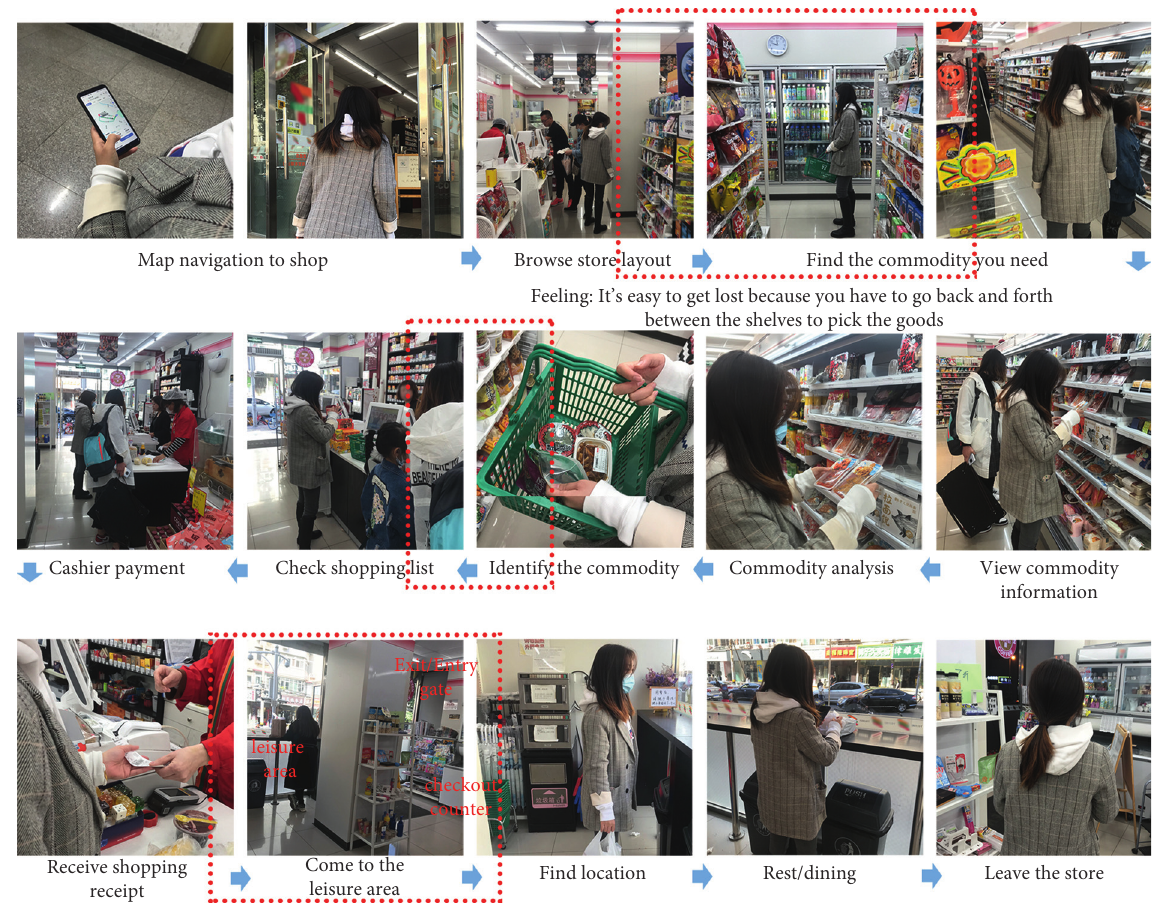
Figure 3: Convenience store service process experience.